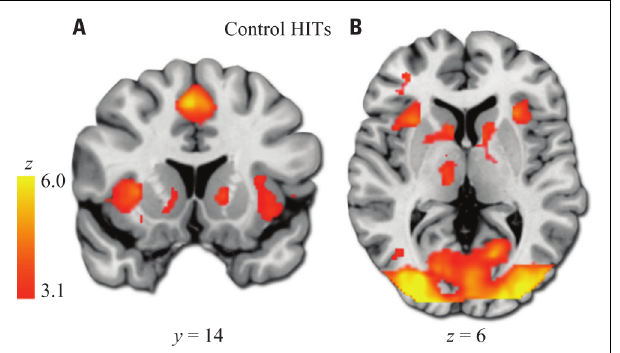
FIGURE 3 | HIT > baseline whole-brain exploratory voxelwise analysis. Coronal (A) and transverse (B) images showing activation of the reward and motivation network regions including anterior insula, dACC, and striatum. Images thresholded at Z > 3.1 and cluster corrected for multiple comparisons with spatial extent p < 0.01.